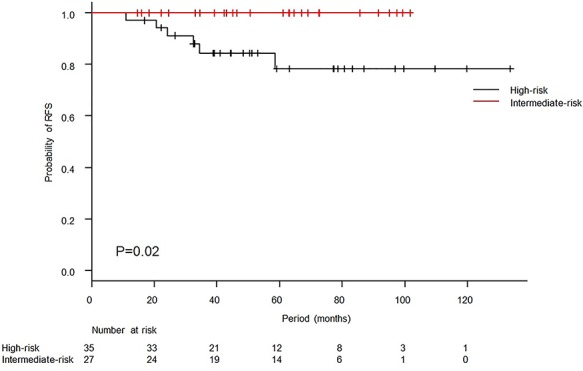
Kaplan–Meier curves of relapse-free survival (RFS) according to prognostic risk factors. The 3-year RFS rates in the intermediate-risk and high-risk groups were 100.0% and 84.3%, respectively. The difference showed significance (P = 0.02, log-rank test).